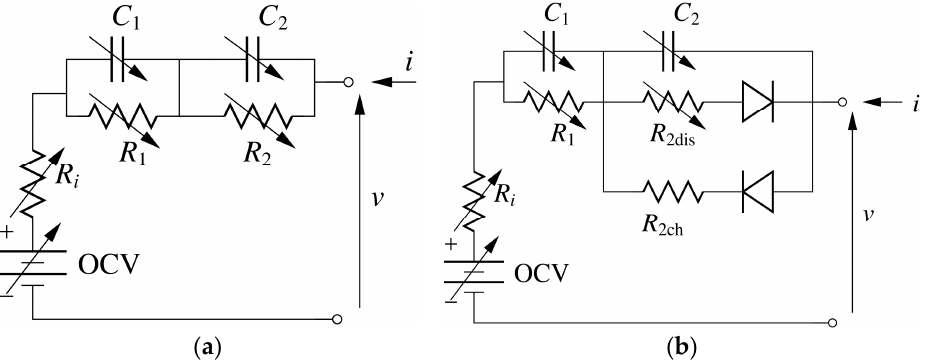
Figure 1. Classic electrical schematic of: ( a ) a single cell; ( b ) modified electrical schematic. OCV is an ideal voltage generator representing the open circuit voltage of the cell.